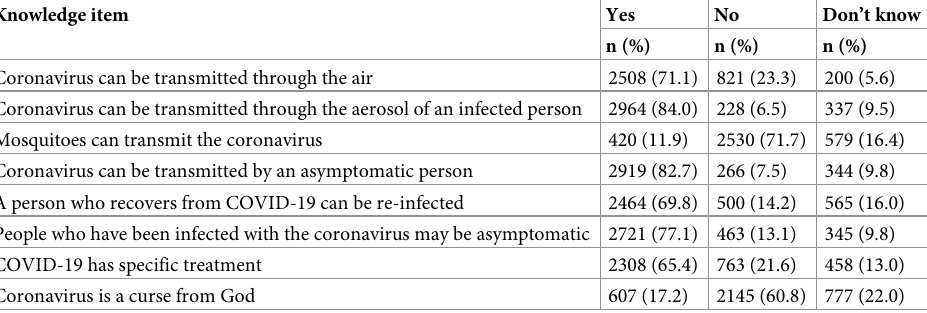
Table 2. COVID-19 related knowledge among